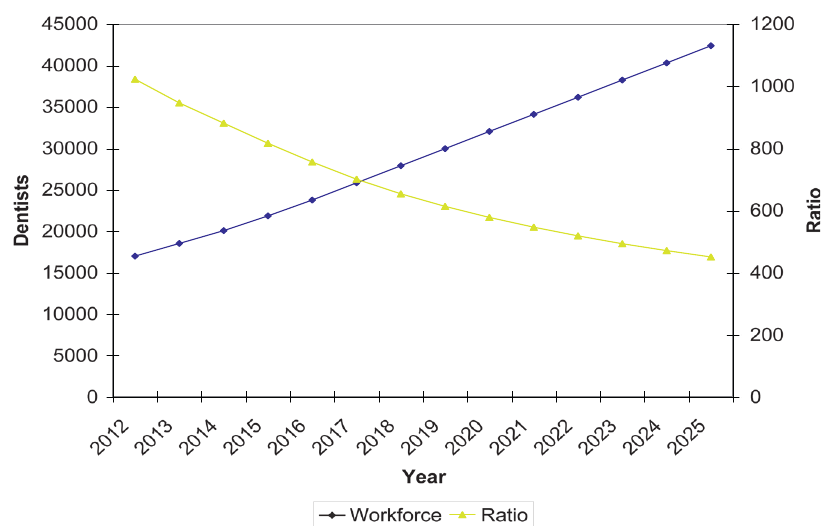
Figure 4 - Projection of dental workforce and ratio of